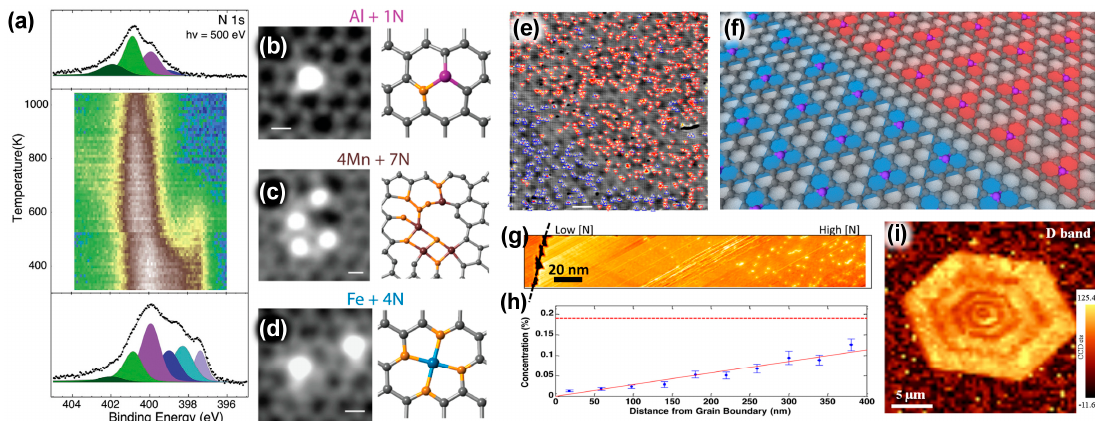
Figure 4. Nitrogen dopant control in NG. ( a ) Thermal evolution of the XPS N1s peak taken on Graphene/Ir(111). A shift to graphitic type dopants is seen as temperature rises. Reproduced with permission from [30]. Copyright Elsevier, 2016. ( b – d ) Scanning tunneling electron microscopy annular dark-field images of ( b ) Al, ( c ) Mn, and ( d ) Fe bonding to pyridinic-N sites in the graphene lattice. Scale bars are 2Å. Reproduced with permission from [67]. Copyright American Chemical Society, 2015. ( e ) Large-area STM image of NG on Cu(111). Nitrogen on different sublattices are marked by red and blue triangles. Scale bar is 10 nm. Reproduced with permission from [16]. Copyright American Chemical Society, 2014. ( f ) A model of nitrogen dopants occupying separate sublattices domains. ( g ) STM image of NG near a grain boundary indicated by the black line. ( h ) N-concentration as a function of the distance from the grain boundary in ( g ). The red dashed line is a linear fit to the data. Reproduced with permission from [21]. Copyright American Chemical Society, 2015. ( i ) Raman mapping of the D band intensity of a NG sample with a concentric hexagonal ring pattern. Reproduced with permission from [20]. Copyright Elsevier, 2018. The rings exhibit alternating low and high D-band intensity which indicate less and more N dopants respectively.